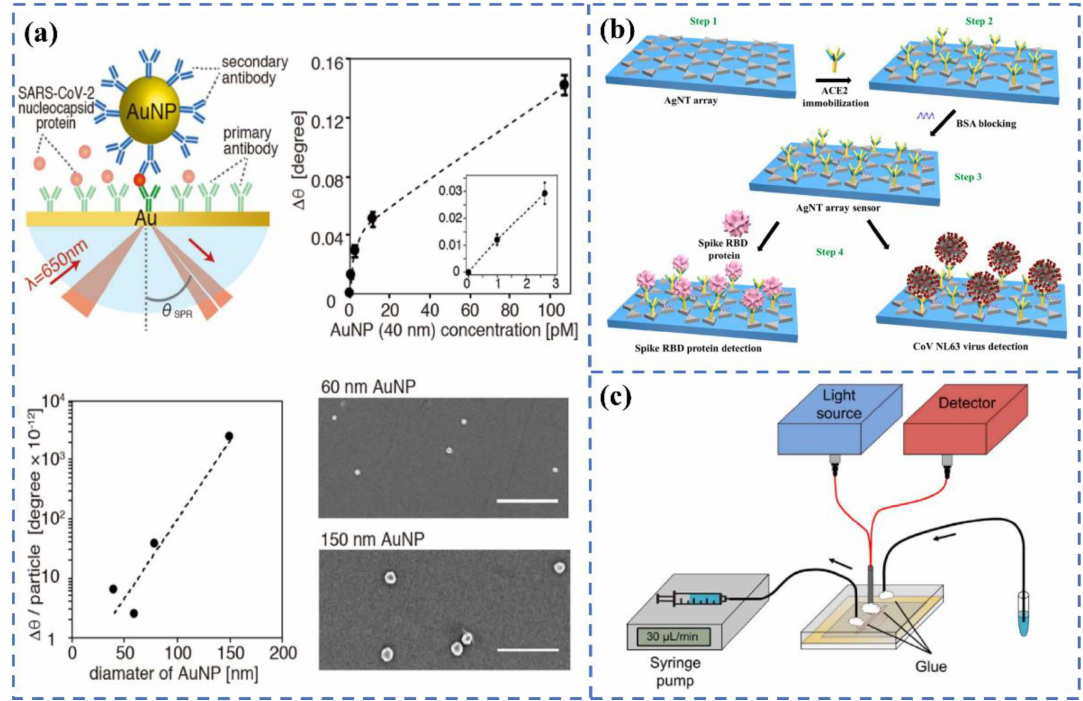
Figure 10. ( a ) Principle of the LSPR biosensor for detecting SARS-CoV-2 nucleocapsid protein using gold nanoparticles. Reprinted with permission from ref. [121]. ( b ) Schematic diagram strategy for spike RBD protein or virus detection. Reprinted with permission from ref. [122]. Copyright 2022, Elsevier. ( c ) The diagram of the opto-microfluidic SPR system. Reprinted with permission from ref. [123]. Copyright 2020,